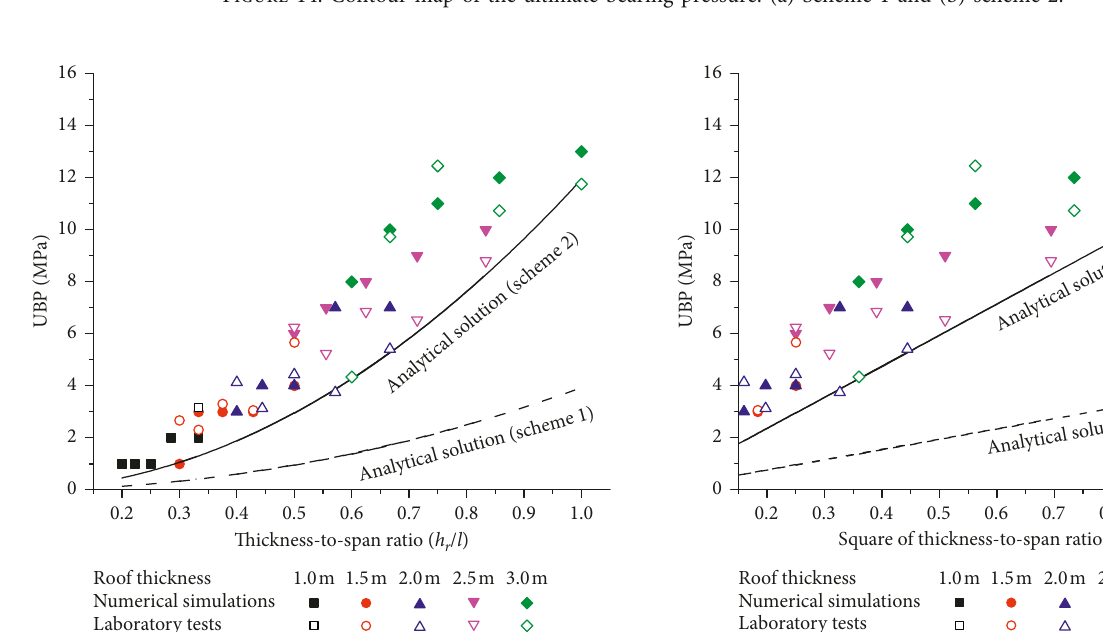
Figure 14: Contour map of the ultimate bearing pressure. (a) Scheme 1 and (b) scheme 2.